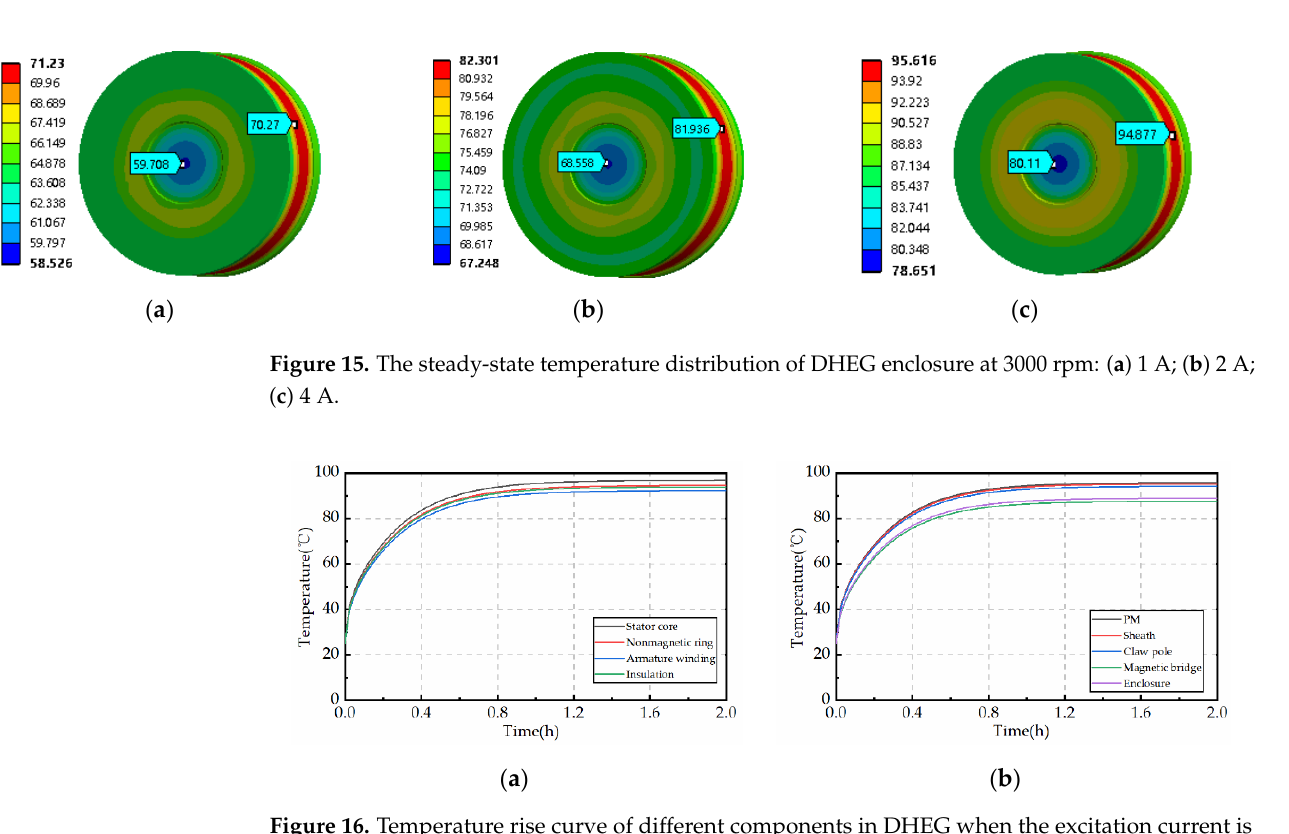
Figure 16. Temperature rise curve of different components in DHEG when the excitation current is 4 A: ( a ) Stator part; ( b ) Rotor part.